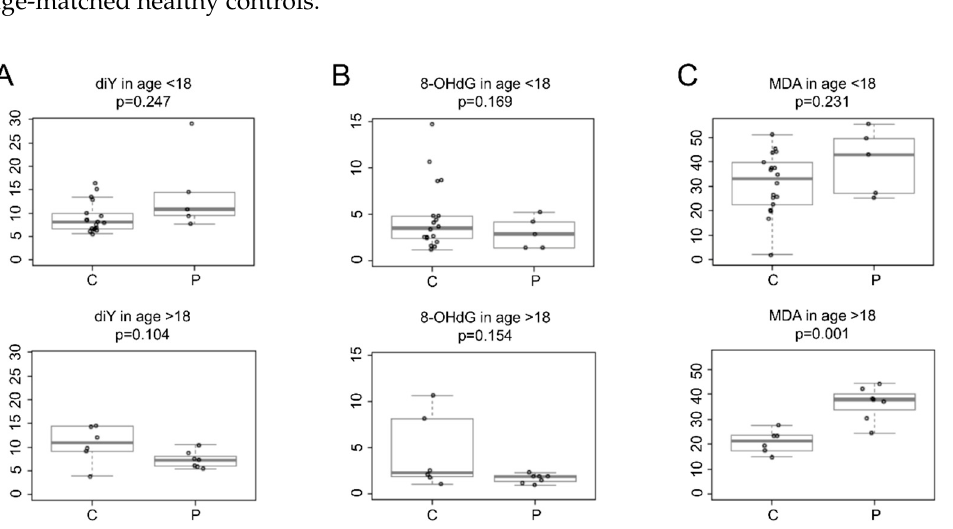
Figure 2. Levels of urinary oxidative biomarkers in healthy controls ( C ) and CCHS patients (P) from two different age groups, i.e., <18 years and >18 years. Boxplots represent the concentration levels (µmol/mol creatinine) of ( A ) o,o ′ -dityrosine (diY), ( B ) 8-hydroxy-2 ′ -deoxyguanosine (8-OHdG), and (C) malondialdehyde (MDA). Values were corrected with urinary creatinine content. p -values were obtained with a two-class t -test.